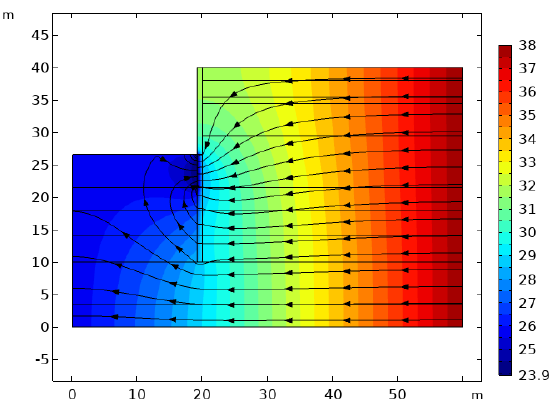
Figure 8. Flow network diagram without waterproof curtain.